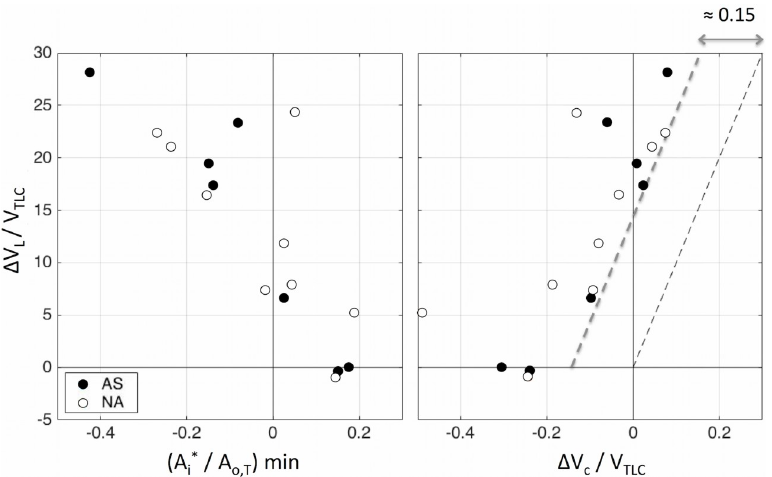
Fig 7. LEFT: Plot of the relative change in mean lung volume ( Δ V L /V TLC ) chosen for breathing after MCh by each � /A subject, vs the corresponding minimum value of A , amongst all segmental airways of each subject (A i o , T This illustrate an inverse association between the variables (R = -0.83, P < 0.001 for all subjects). Each data point corresponds to a subject of the AS (blue) and NA, (red) groups. RIGHT: Plot showing the Inverse association (R = 0.76, P < 0.001 for all subjects) between Δ V C /V TLC and the critical change in lung volume causing for first airway ) in both groups. Note that the relative change in MLV for each subject after MCh was always at to close ( Δ V Crit /V TLC least 15% higher of that for predicting the onset of the first airway closure in each subject.